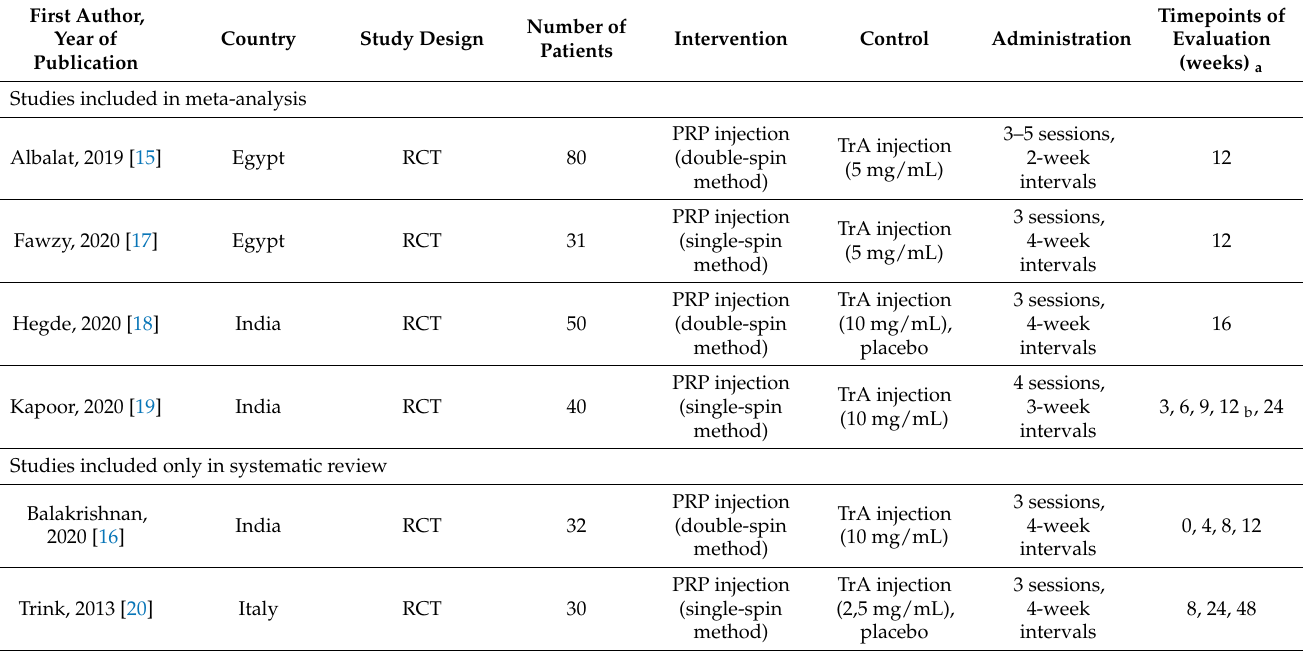
Table 1. Main characteristics of the included